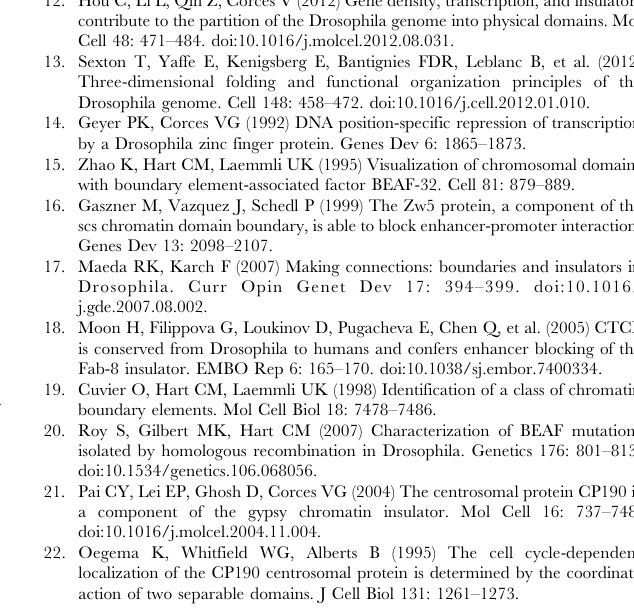
Figure S5 Venn diagrams showing the genome-wide overlap between (A) BEAF-32, CP190 and Chromator in BG3 cells, and publicly available modENCODE ChIP-chip data [2,3]. There is a considerably smaller number of BEAF32 peaks in BG3 cells than those observed in other cell types, however the trend of association with CP190 and Chromator remains the same in both S2 and